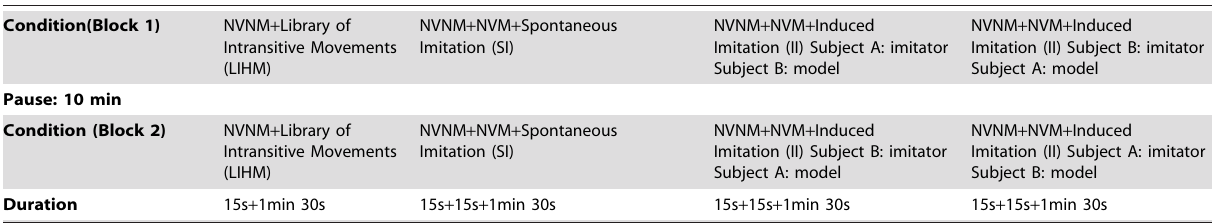
Table 1. Experimental